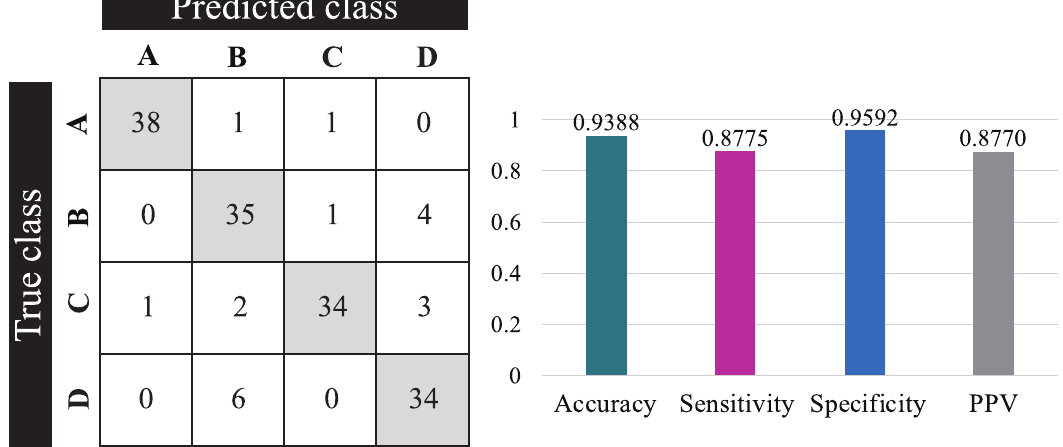
Fig 8. Classification results of SVM model using the testing set after 100 repetitions of the algorithm. Left: confusion matrix for classes A (earwax plug), B (myringosclerosis), C (chronic otitis media) and D (normal); Right: average evaluation metrics.